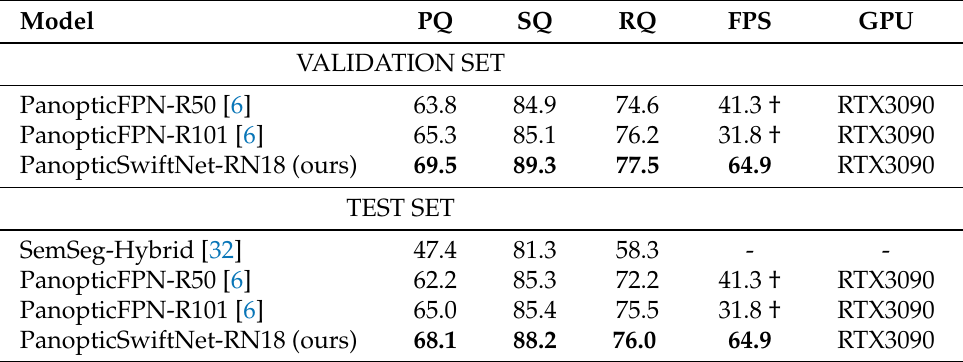
Table 1. Performance evaluation of panoptic segmentation methods 512 × 512 images from the BSB Aerial dataset. FPS denotes frames per second from PyTorch and Python. †—denotes our estimates that measure the inference speed of uninitialized models which on average detect less than 1 instance across the validation dataset.